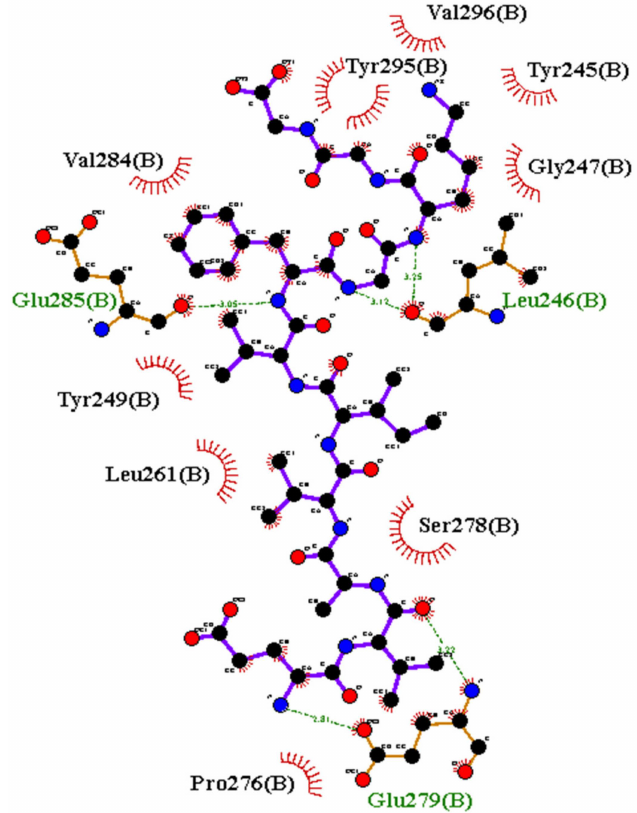
Figure 10. Binding site residues of BBM Fragment 1 protein with the peptide P2 (dock10). Interactions are calculated and figures are generated using LigPlot + 2.2.5.